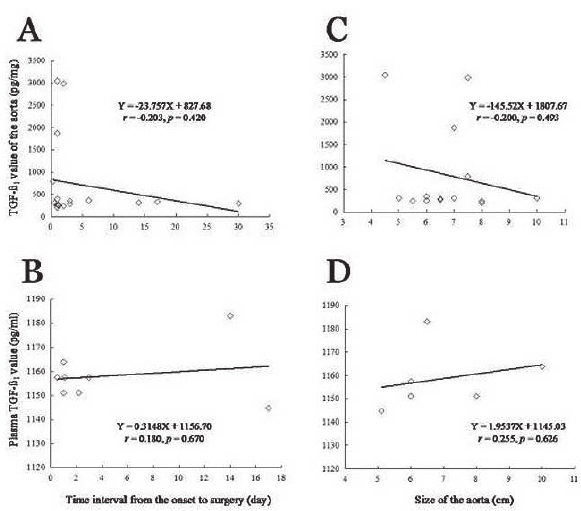
Fig. 7. Correlation between the plasma or aortic TGF-ß level and 1 the time interval from the onset to surgery or the maximal dimension of the aorta in aortic dissection patients: (A) aortic TGF-ß and (B) 1 plasma TGF-ß corresponding to the time interval from the onset 1 to surgery; and (C) aortic TGF-ß and (D) plasma TGF-ß 1 1 corresponding to the maximal dimensions of the aorta in the patients with aortic dissection.